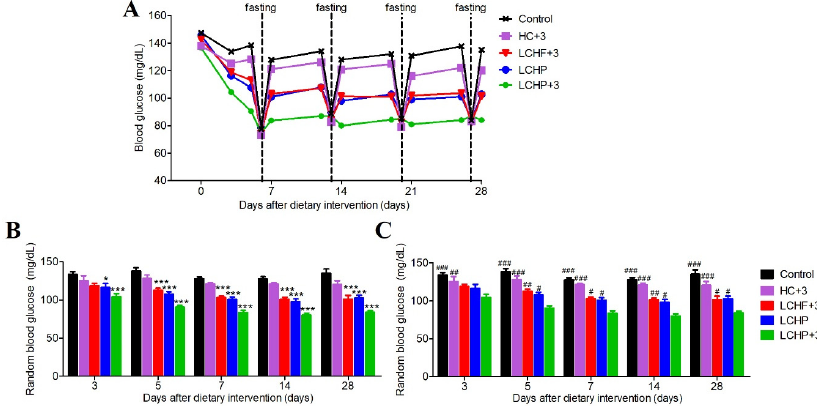
Figure 1. Effects of various experimental diets on blood glucose levels. The five study diets used include a high-carbohydrate/low-omega-3 (Control) diet, a high-carbohydrate/high-omega-3 (HC+3) diet, a low-carbohydrate/high-fat/high-omega-3 (LCHF+3) diet, a low-carbohydrate/high-protein/low-omega-3 (LCHP) diet, and a low-carbohydrate/high-protein/high-omega-3 (LCHP+3) diet (see Tables S1 and S2 for details). ( A ) Random and fasting blood glucose levels at various time points during the feeding duration; ( B ) Representative statistical data for random blood glucose measurements; values are shown as mean ± SEM. Compared with the Control group, * p < 0.05, *** p < 0.001; ( C ) Representative statistical data for random blood glucose measurements; values are shown as mean ± SEM. Compared with the LCHP+3 group, # p < 0.05, ## p < 0.01, ### p < 0.001. n = 8 per group.